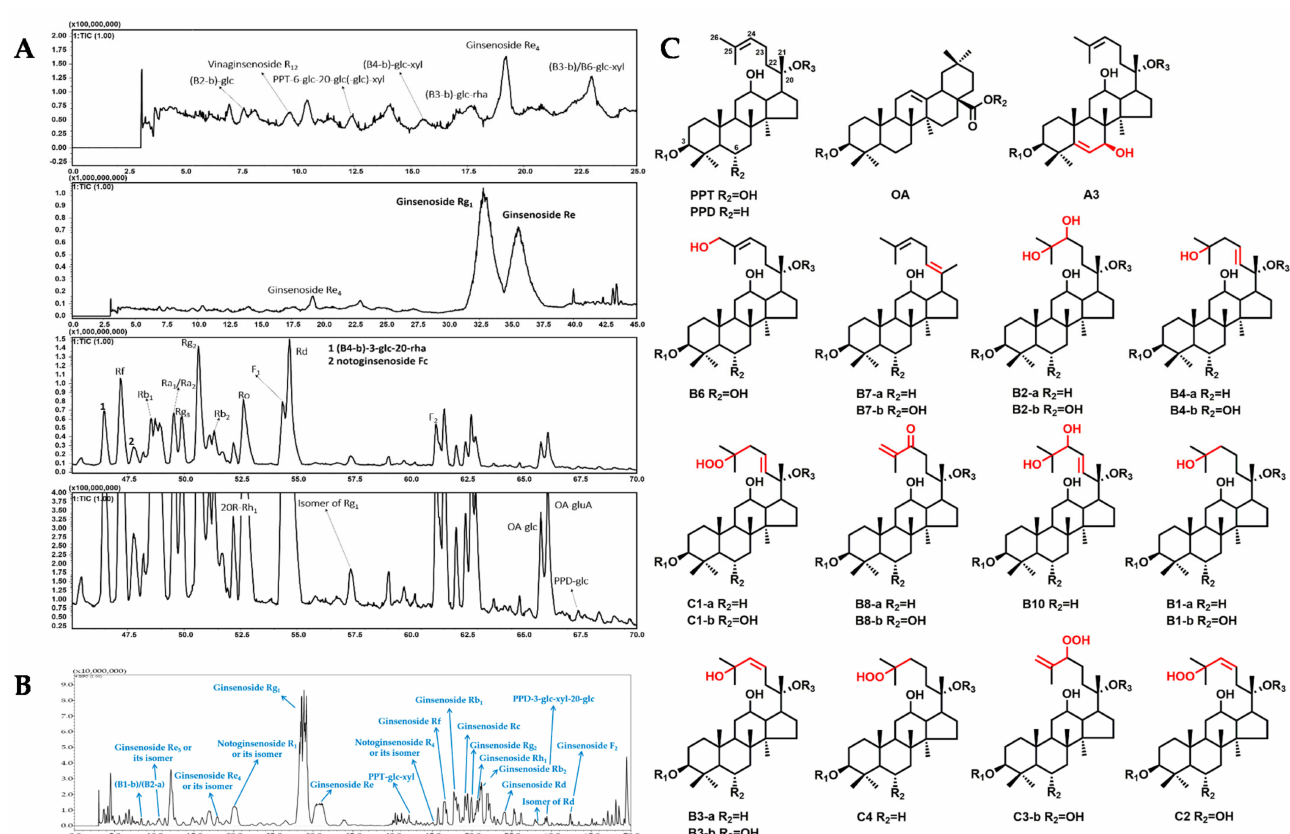
Figure 2. TIC chromatogram of wild ginseng (no. 20) obtained by HPLC-IT-TOF-MS n ( A ), TIC chromatogram of ginseng under forest (no. 18) with 18 of the 21 saponins which could be detected from all three types of ginseng (( B ); 3 saponins could not be directly marked in TIC chromatogram due to the extremely low intensity), as well as the 15 structure types of saponins tentatively identified from wild ginseng (nos. 19 and 20), ginseng under forest (no. 18), and cultivated ginseng (no. 25; ( C ); R 1 , R 2 , and R 3 represented sugar residues or substituent groups when not specified under each structure type). Table 1. Summary of saponins tentatively identified from wild ginseng (W-GS), ginseng under